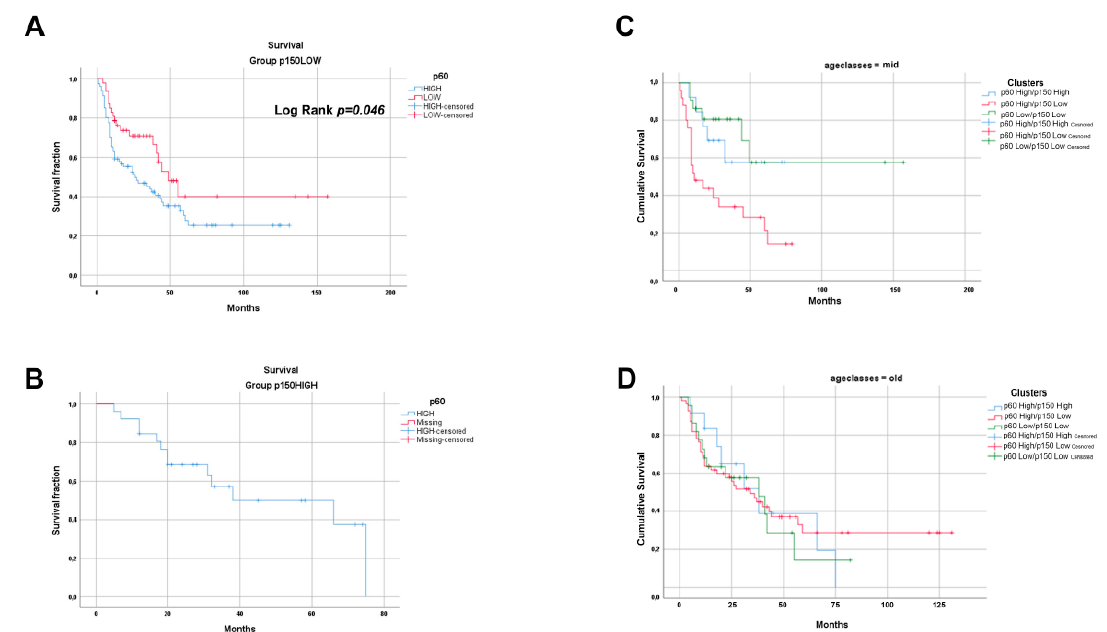
Figure 2. Survival analysis by Kaplan–Meier curves. The picture shows CAF-1 p60 HIGH and CAF-1 p60 LOW survival curves in the study population grouped by CAF-1 p150 staining score. ( A ) CAF-1 p60 HIGH and CAF-1 p60 LOW curves in p150 LOW group. ( B ) Since CAF-1 HIGH category is only associated with CAF-1 p60 HIGH staining score, only this curve is shown. Statistical differences between curves were assessed by log-rank test, where applicable. ( C , D ) Kaplan–Meier curves survival analysis of the three clusters stratified by age class were performed ( C ) for age class “41–60” and ( D ) for age class “>60”. Difference between curves was statistically significant in mid-age group (40–60 years old) (Log-Rank test p = 0.005).